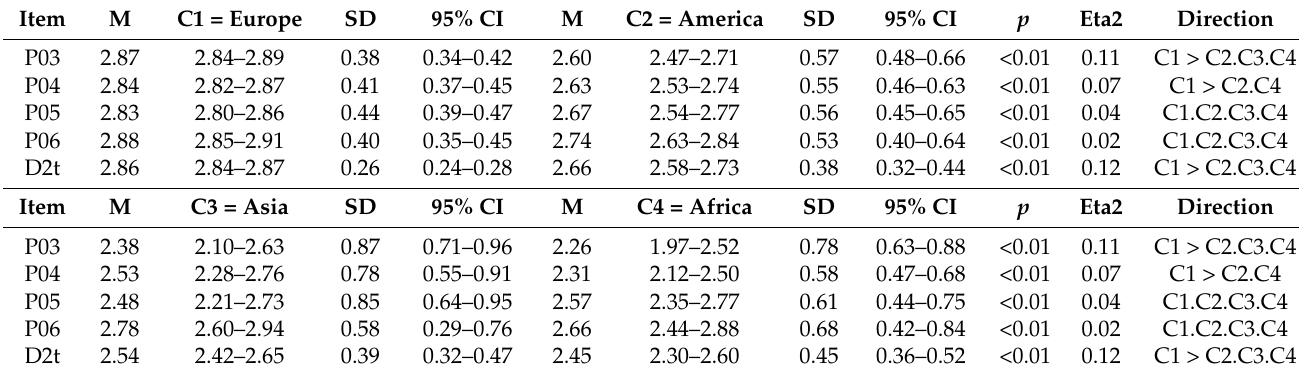
Table 12. ANOVA for independent samples by Continent for dimension